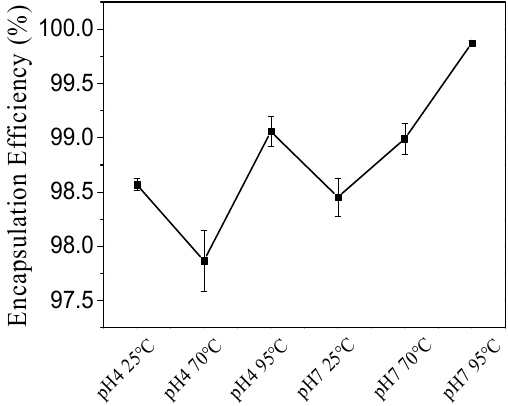
Figure 4. Encapsulation efficiency of CA in LF NPs.